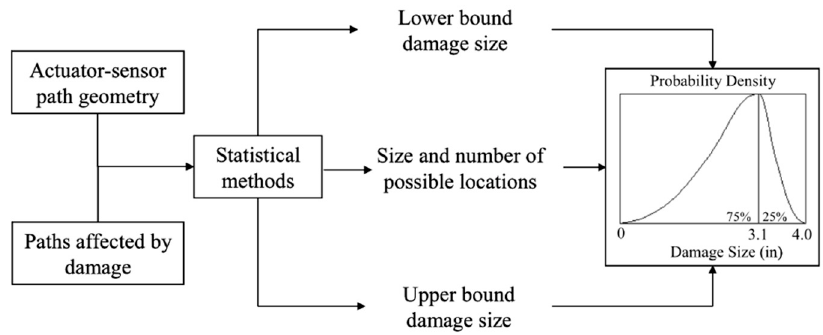
Figure 14. Probable damage sizing using statistical methods.